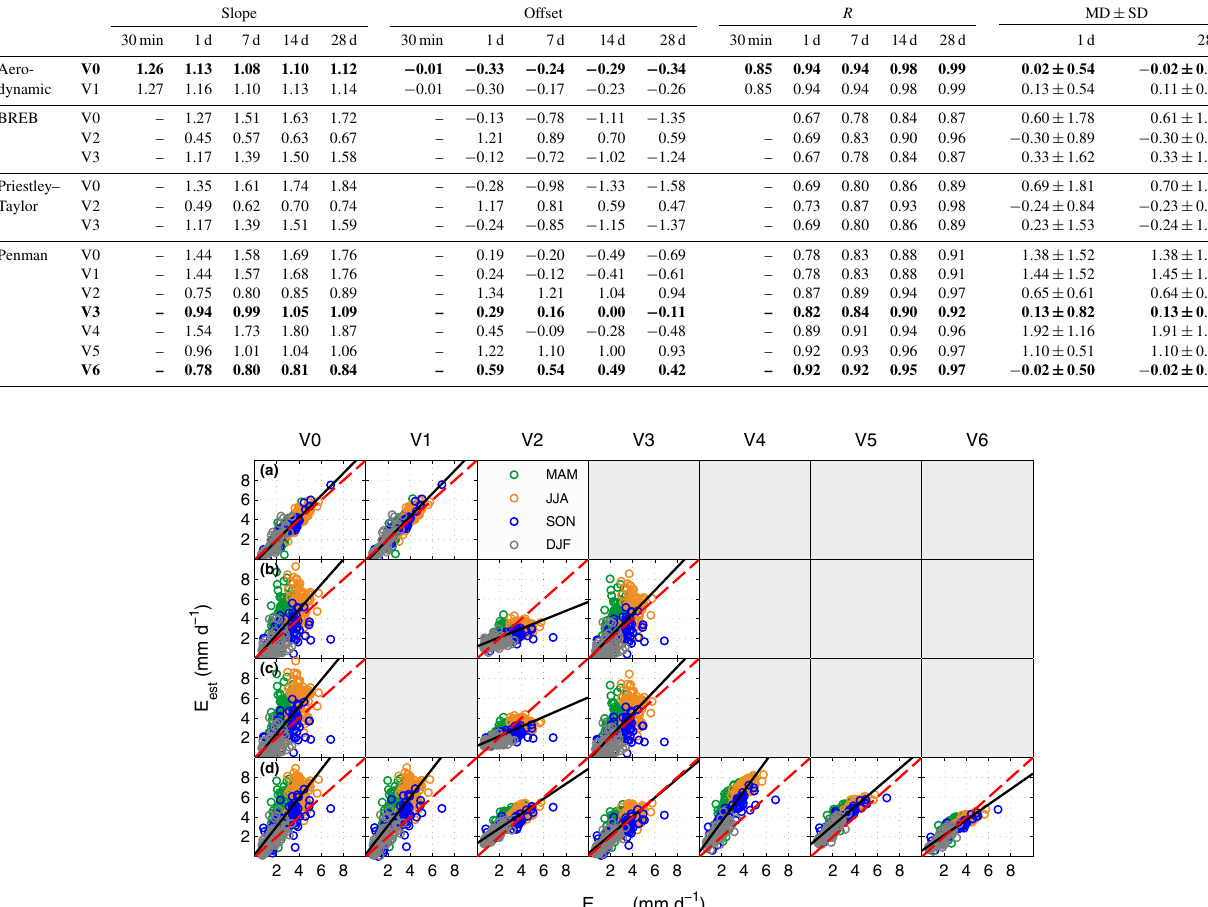
Table 6. Slope and offset of the regression lines between the evaporation estimates calculated with the different equations and the evaporation measurements and the corresponding correlation coefficient ( R ), for averaging periods of 30min, 1, 7, 14, and 28 days. Mean difference (MD) and standard deviation (SD) in mm d − 1 are shown for 1 and 28d as no relevant differences for the other time intervals exist. V0 to V6 indicate the different sensitivity studies (see Table 2). The best fitting solutions are indicated with bold numbers.